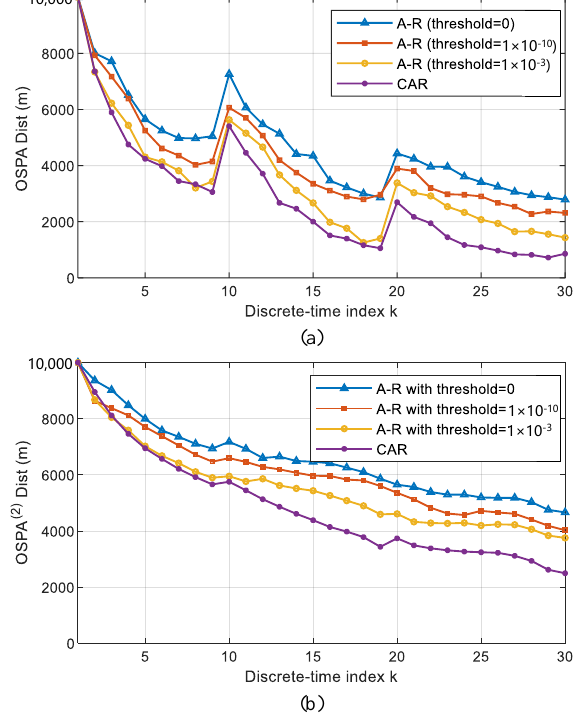
Figure 12. Performance comparison in multi-target Scenario 2: ( a ) OSPA distance; ( b ) OSPA ( 2 ) distance. Table 2. Average performance comparison in Scenario